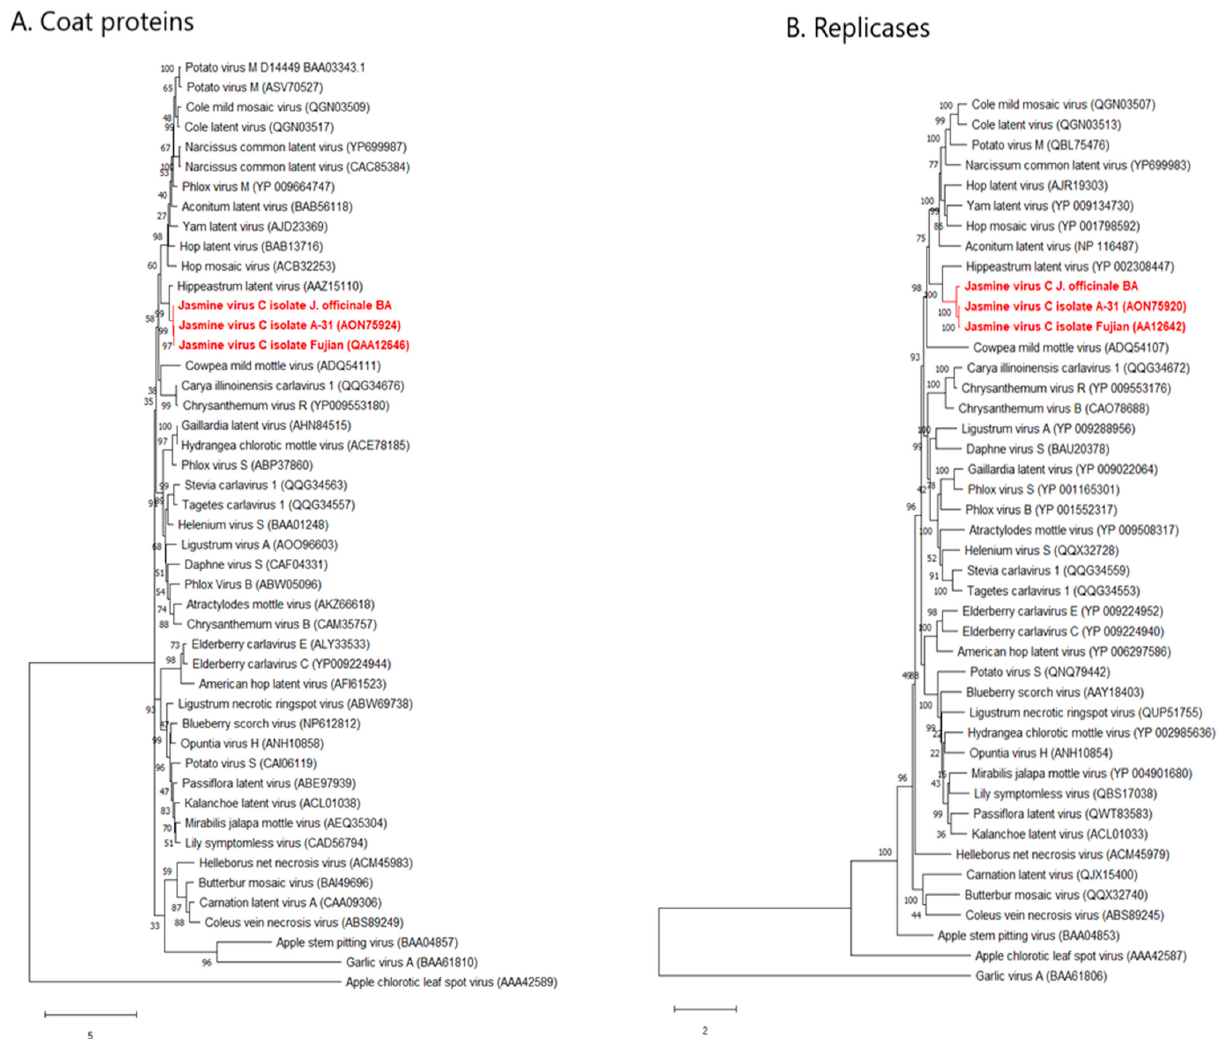
Figure 3. Maximum likelihood phylogenetic analysis of coat proteins ( A ) and ORF1 polyprotein ( B ) of the JaVC isolates (in red) versus other carlaviruses and outgroup flexivirids homolog proteins. GenBank accession numbers are on the tips (refer also to Supplementary Materials Table S2).